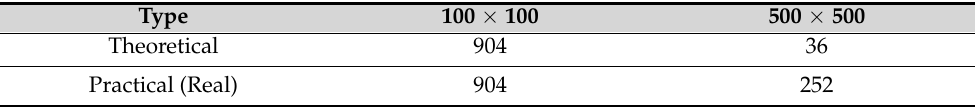
Table 3. Data standardization matching process between